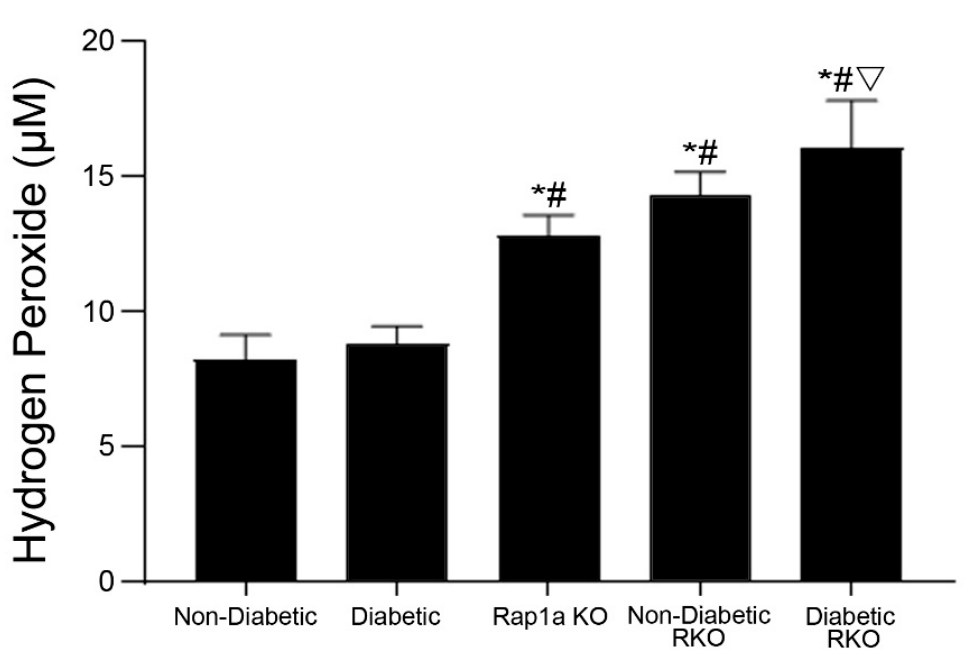
Figure 7. Rap1a KO and RKO cardiac fibroblasts embedded in non-diabetic collagen exhibited significantly higher concentrations of hydrogen peroxide. Cardiac fibroblasts isolated from non- diabetic, diabetic, Rap1a KO, non-diabetic RKO, and diabetic RKO mouse hearts were embedded in non-diabetic collagen for 7 days. Protein lysates were isolated and examined for concentration of hydrogen peroxide. Mean ± SEM were graphed with n = 5–10 and statistical analysis consisted of a one-way ANOVA, followed by a Fisher’s Least Significant Difference post hoc. Symbols above each bar indicate significance between a specific group ( p < 0.05; * vs. non-diabetic in non-db, # vs. diabetic in non-db, (cid:53) vs. Rap1a KO in non-db). H 2 O 2 concentration in Rap1a KO and RKO cardiac was not changed by treatment with exogenous AGEs, EPAC, or matrix components. Rap1a KO fibroblasts’ H 2 O 2 concentration was not significantly altered by matrix components, exogenous AGEs, or EPAC treatment (Figure 8C; two-way ANOVA, Interaction p = 0.6933, Matrix p = 0.6476, and Treatment p = 0.6762). Likewise, H 2 O 2 levels in non-diabetic RKO were not significantly impacted by exogenous AGEs, EPAC, or matrices (Figure 8D; two-way ANOVA, Interaction p = 0.9650, Matrix p = 0.9315, and Treatment p = 0.9908). Lastly, diabetic RKO fibroblasts’ regulation of H 2 O 2 levels was not affected by pharmacological treatments or source of matrix (Figure 8E; two-way ANOVA, Interaction p = 0.8877, Matrix p = 0.8317, and Treatment p =